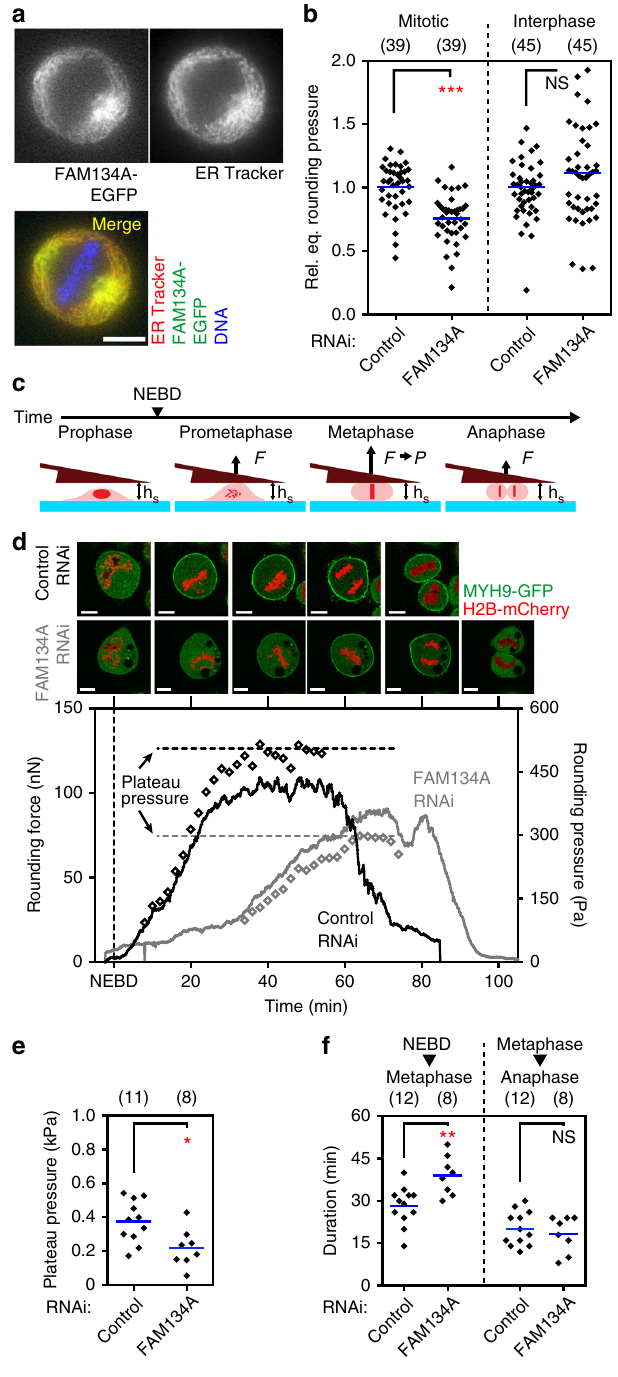
Fig. 4 The endoplasmic reticulum (ER) protein FAM134A is required for rounding pressure during mitosis and timely prometaphase progression. a Co-localization of human FAM134A-EGFP and an ER marker in mitosis. Blue, DNA; Green, FAM134A-EGFP; Red, ER Tracker, an ER marker. Yellow regions represent co-localization between FAM134A and ER. Scale bar, 10 µ m. b Relative equilibrium (Rel. eq.) rounding pressure of mitotic and interphase cells upon depletion of FAM134A by RNAi. Values relative to average rounding pressure of control are shown. See Supplementary Fig. 6 for a description of the assay used and for full results for all genes tested. c Depiction of the trans-mitotic height con fi nement assay used to determine the intracellular pressure of a cell rounding against a wedged cantilever (brown) held at a height h s of 10 µ m. P , rounding pressure; F , rounding force. Blue, glass surface. d Representative confocal microscopy images (top) and force traces (bottom) of H2B-mCherry and MYH9-EGFP expressing RNAi treated HeLa cells submitted to the assay depicted in c . Lines represent force traces, open diamonds represent rounding pressure values. NEBD, nuclear envelope breakdown. Scale bars, 10 µ m. e Plateau pressure of metaphase cells as depicted in d . f Duration from NEBD to metaphase plate formation (left) and from metaphase plate formation to anaphase onset (right) for cells submitted to the assay depicted in c . Each black diamond represents one cell. ‘ ( n ) ’ denotes number of cells measured. Blue bars, mean. Statistical signi fi cance was determined by Mann – Whitney U -test (NS, p > 0.05; * p ≤ 0.05; ** p < 0.01; *** p <